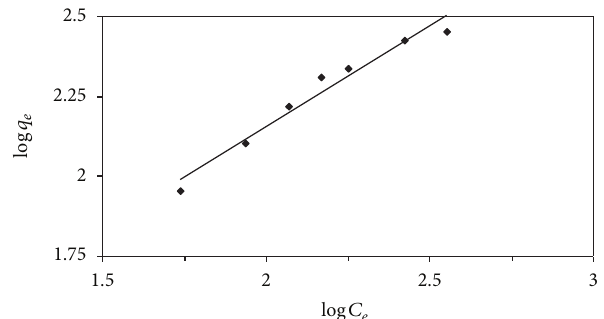
Figure 7: Freundlich plot for the adsorption of lead (II) ions onto the activated carbon (SAC2) at 298.15